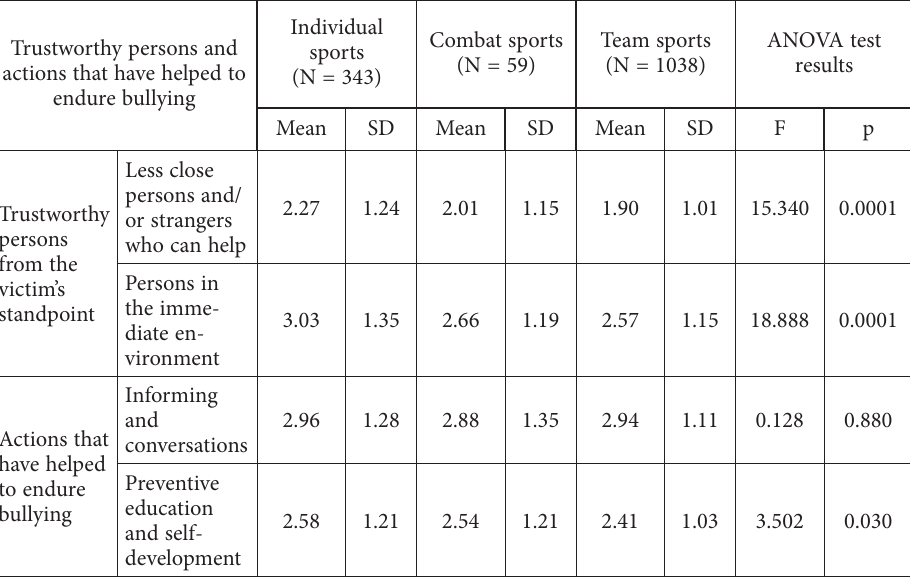
Table 5. Trustworthy persons and actions that have helped to endure bullying and harassment: individual, combat, team sports types